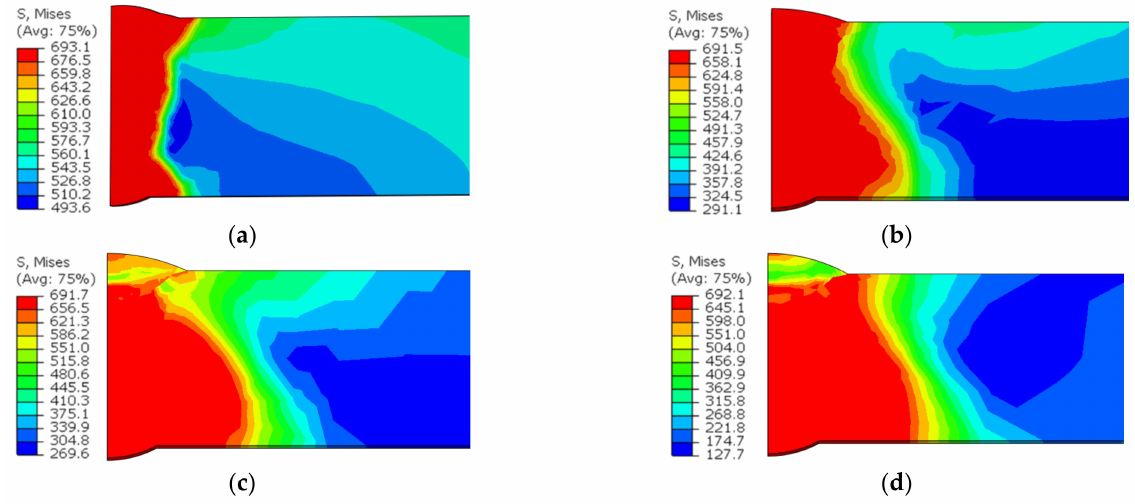
Figure 17. Equivalent stress distribution when the maximum reaches the material yield strength with butt gap of: ( a ) 0 mm; ( b ) 1 mm; ( c ) 2 mm; ( d ) 3 mm.